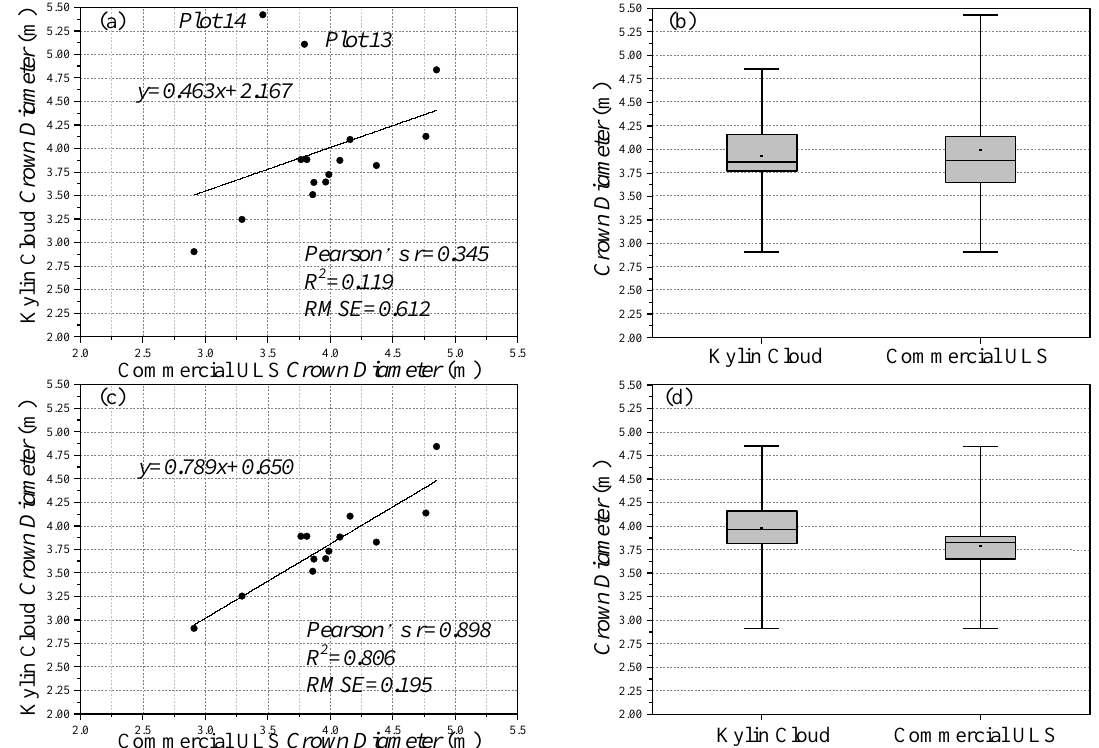
Figure 15. Comparison of crown diameter estimated using different platforms. ( a ) Scatterplots of crown diameter derived from Kylin Cloud and the commercial ULS. ( b ) Boxplots of crown diameter derived from Kylin Cloud and the commercial ULS. ( c ) Scatterplots of crown diameter derived from Kylin Cloud and the commercial ULS without the outliers. ( d ) Boxplots of crown diameter derived from Kylin Cloud and the commercial ULS without the outliers.